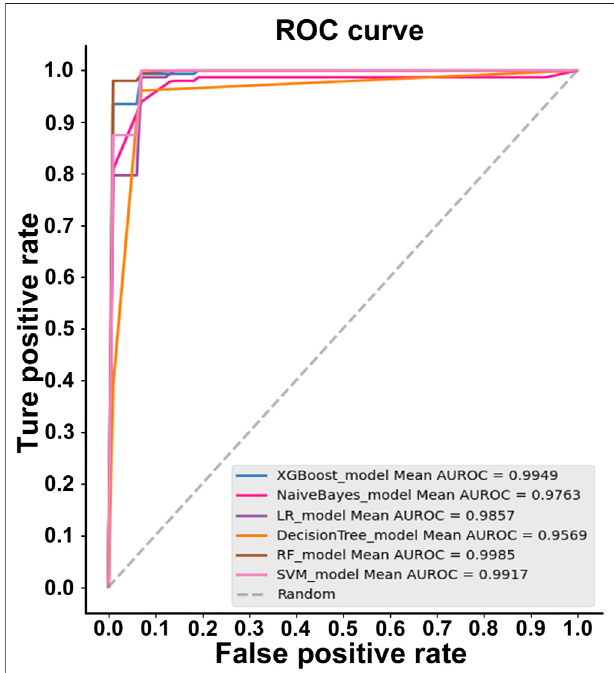
FIGURE 2 | ROC curves for the best performing feature with different classi fi ers.